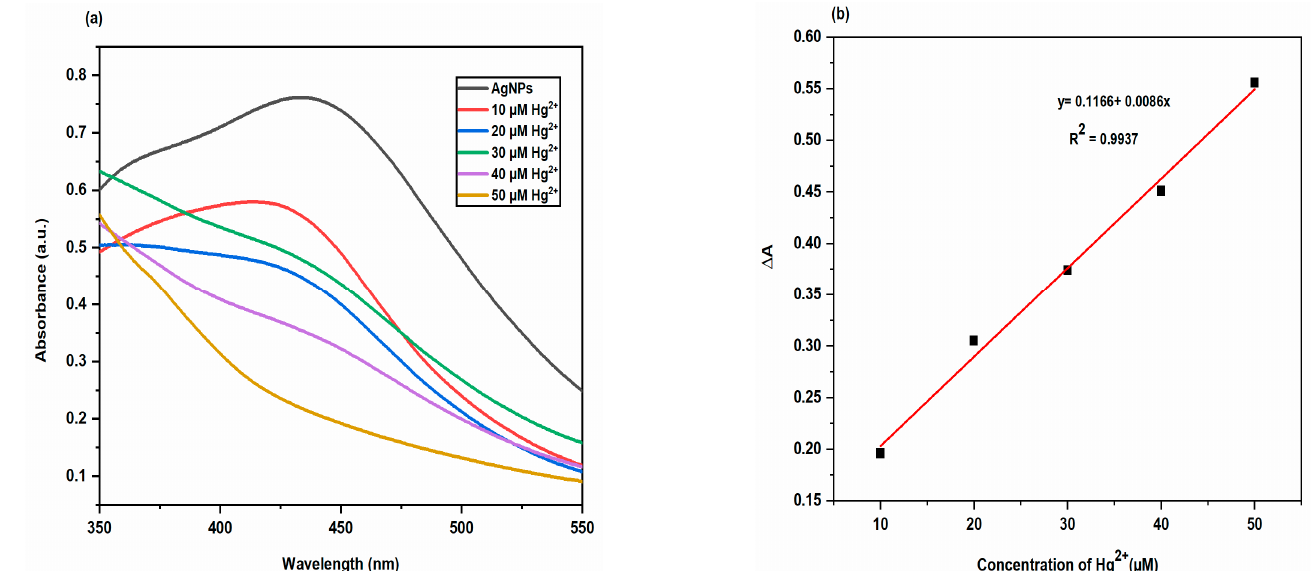
Figure 17. ( a ) UV-Vis spectra of AgNPs solutions in the absencs and presence of Hg 2+ ions at different concentrations ( b ) Plot of ∆ A values for biosynthesized AgNPs solutions containing Hg 2+ ions at different concentrations versus Hg 2+ concentration.